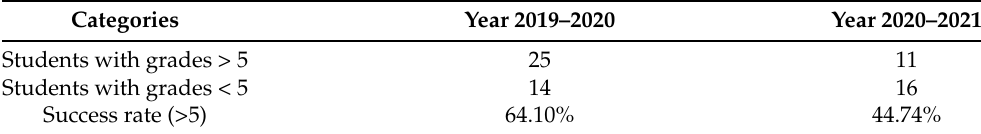
Table 9. Final test results and success rate .